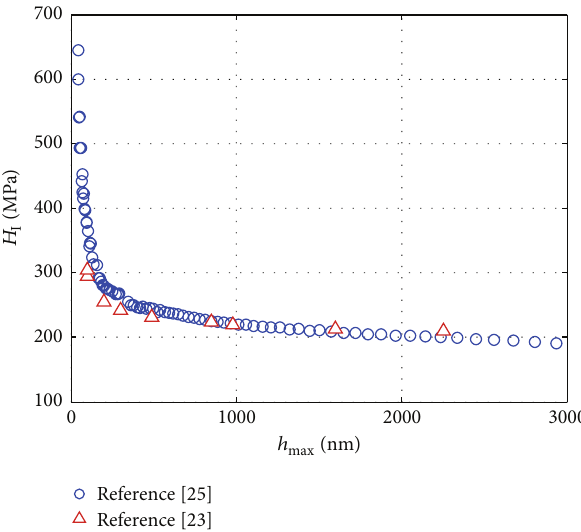
Figure 3: Universal hardness 𝐻 U versus ℎ max for various polymers redrawn from [15] (PC, PS (a), PMMA (a)), [28] (PS (b), PMMA (b)), and [25] (epoxy with 5s loading time).